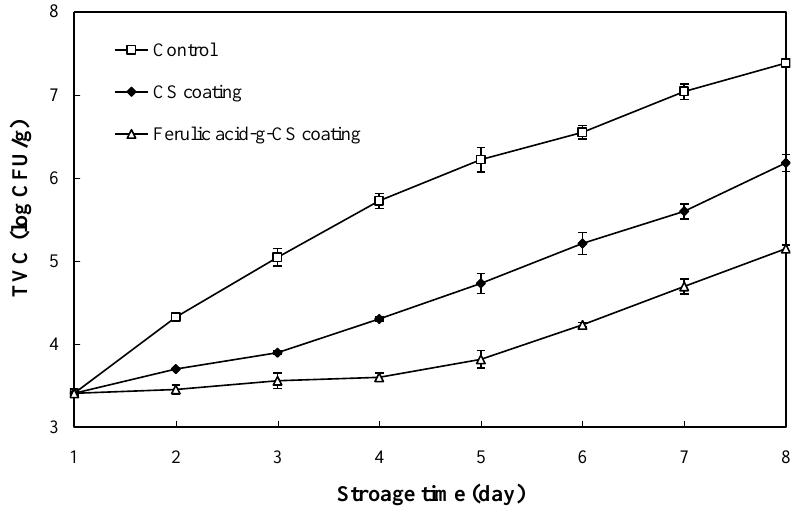
Figure 1. Changes in the total viable counts (TVC) of pork in the control group, CS) coating group and ferulic acid-g-CS coating group at 4 °C for 8 days. Data are presented as means ± SD of tripli- cates.